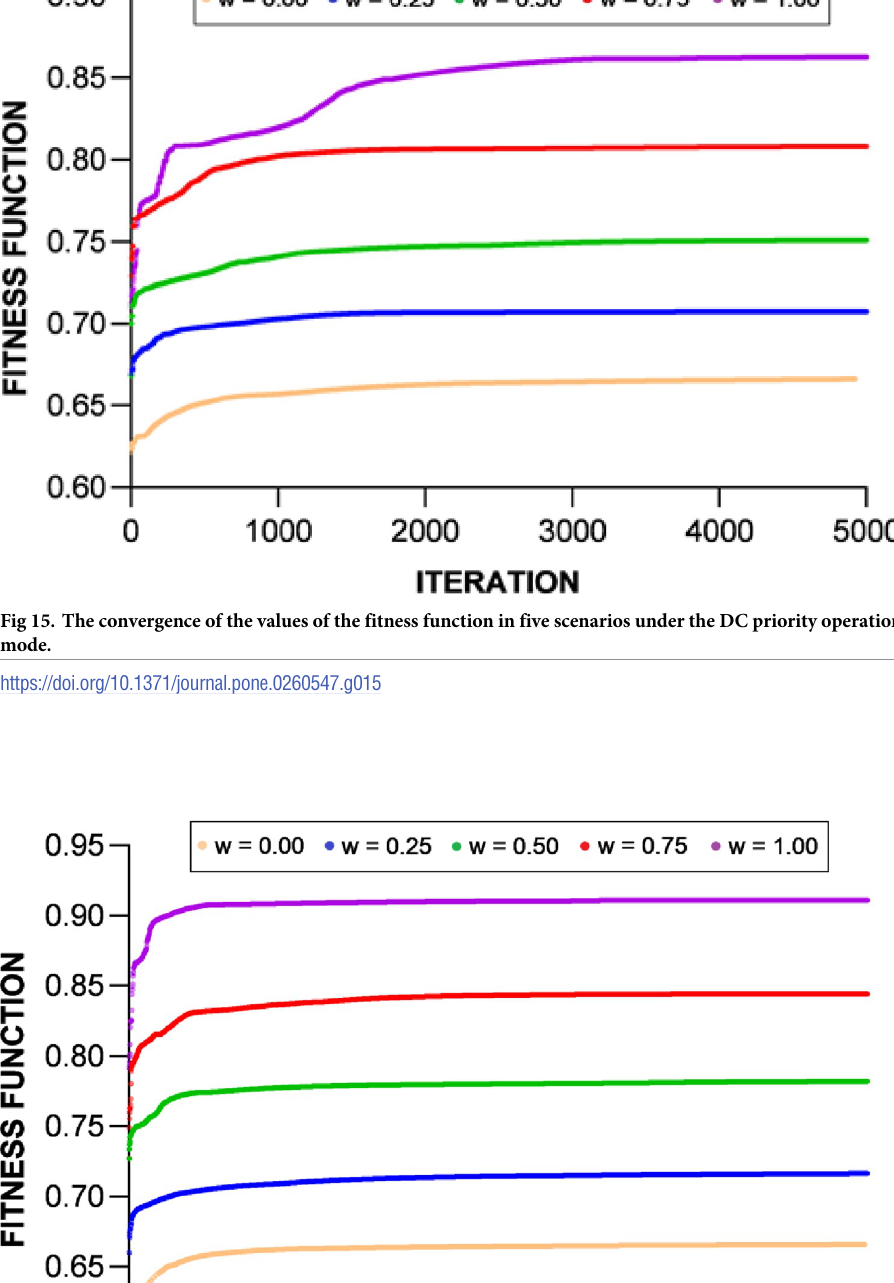
PLOS ONE | https://doi.org/10.1371/journal.pone.0260547 December1,